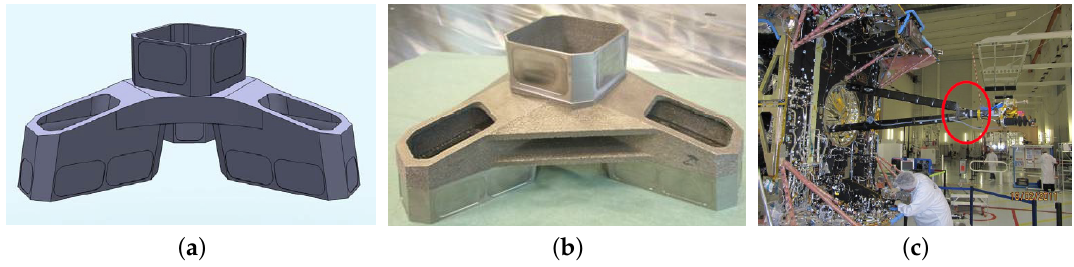
Figure 9. Flight AM part [97]: ( a ) the CAD model; ( b ) the manufactured part; and ( c ) its location the satellite.